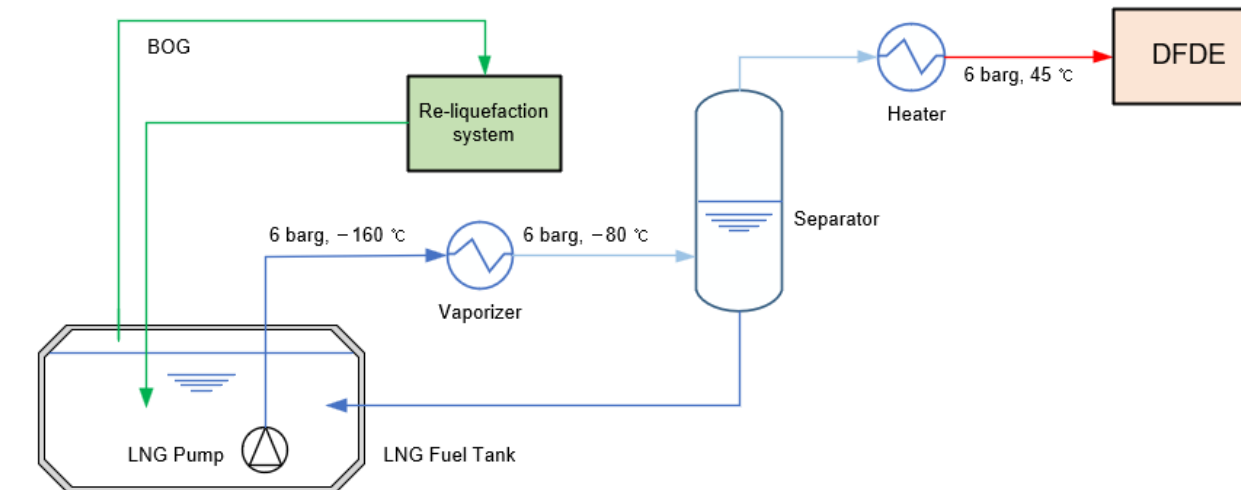
Figure 3. Proposed LNG fuel gas supply system for the DFDE Engine.